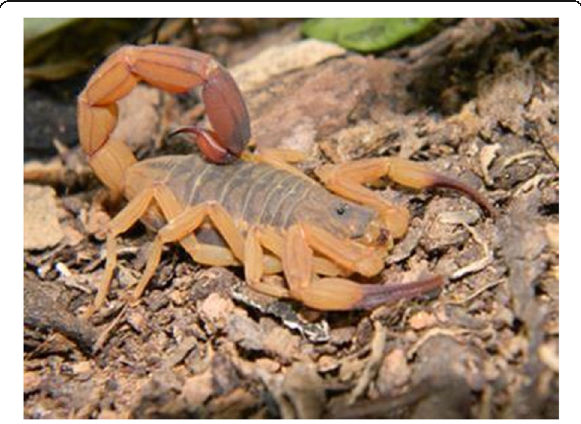
Fig. 1 Tityus serrulatus. Known as the yellow scorpion, T. serrulatus is 5 to 7 cm long, with the third and fourth segments of the metasoma serrated, and parthenogenetic reproduction. Source: Brazilian Ministry of Health [6]. Image copyright by Denise Cândido, reproduced with